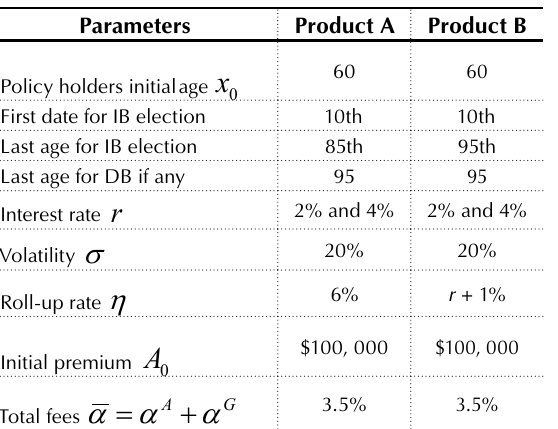
γ γ =  as a function of time t and moneyness G